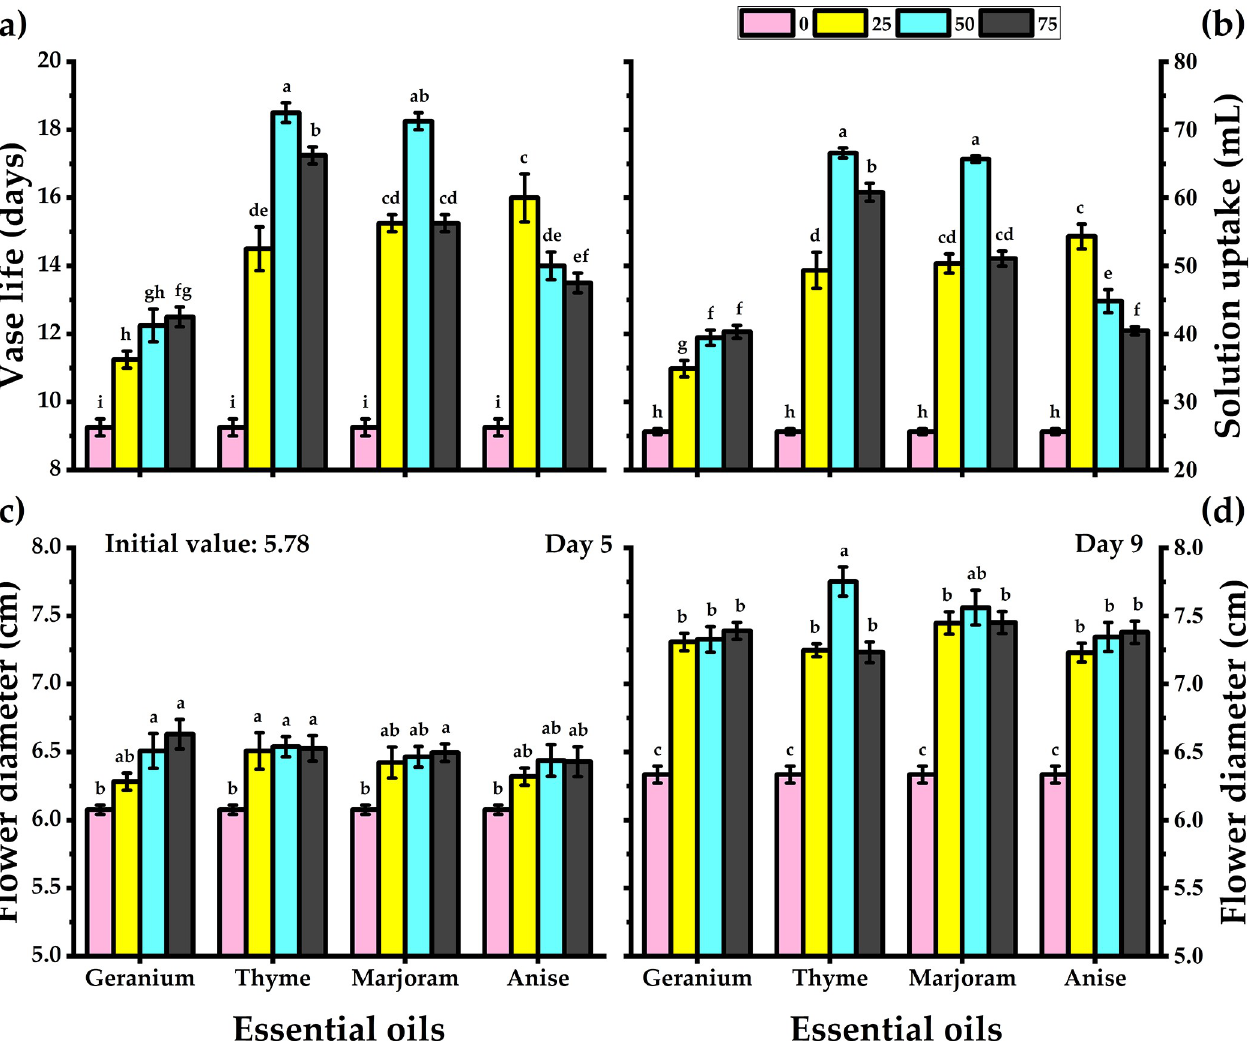
Fig 2. Response of carnation cut flowers to geranium, thyme, marjoram, and anise essential oils at 0, 25, 50, and 75 mg/L concentrations as preservative solutions on the vase life (a), solution uptake (b), and flower diameter (c and d) at day 5 and day 9 of vase life period. Bars with the same letters are not significantly differed at p � 0.05